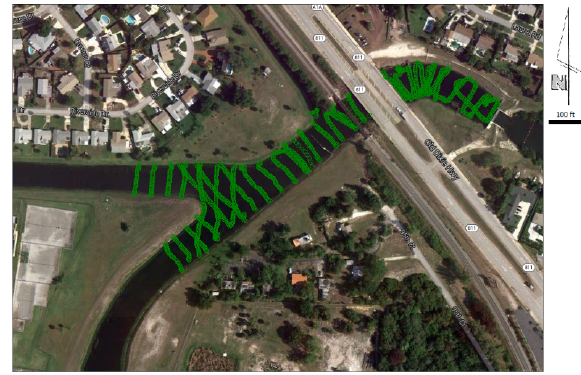
Figure 3: Locations of depth measurements.